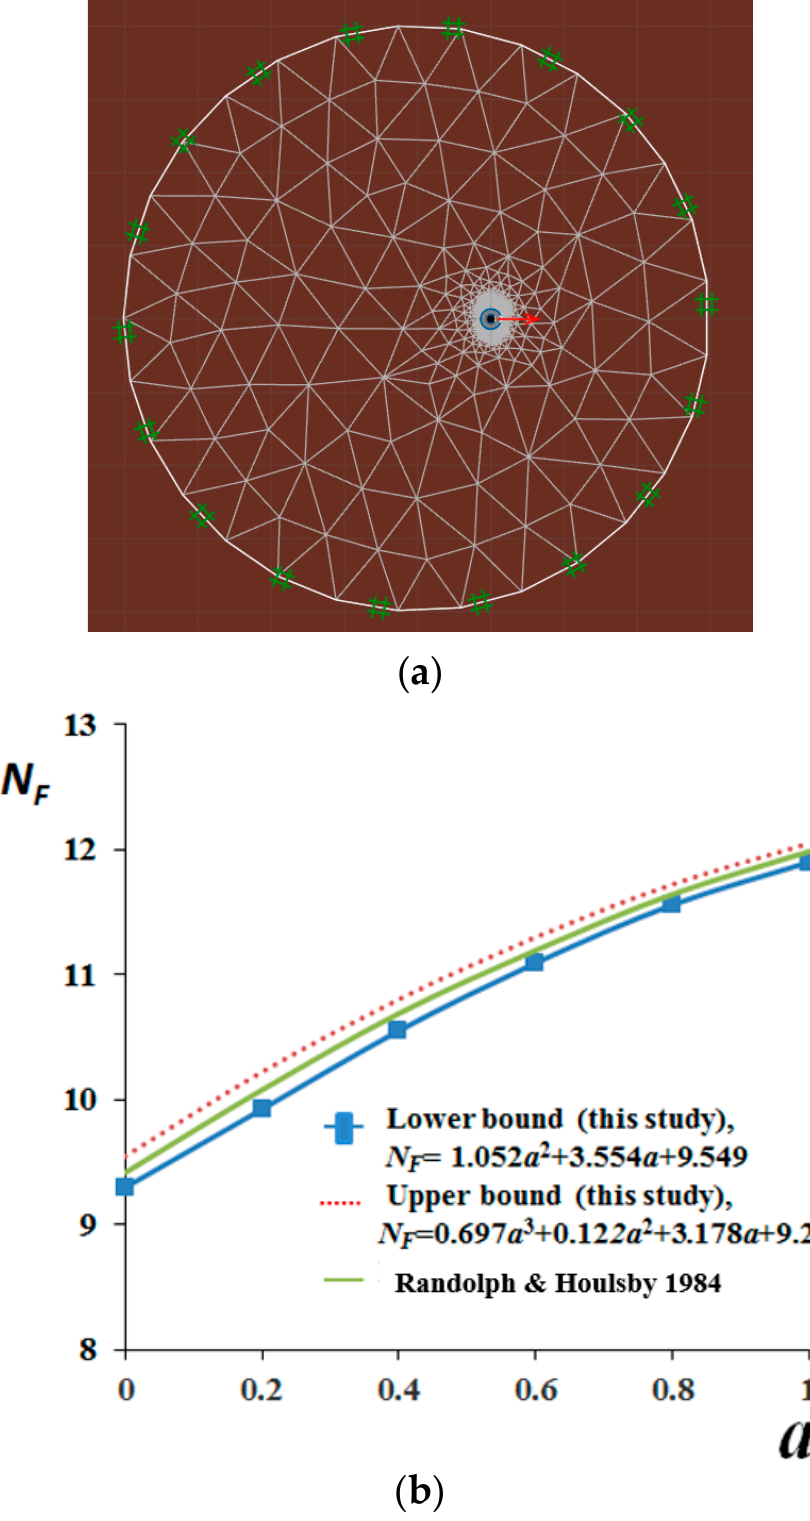
Figure 4. Calculation results for circular-pile model. ( a ) circular-pile-model self-adaptive computing grid; ( b ) a comparison of results calculated by Randolph and Houlsby (1984) with those using the method from this study. ( α : pile–soil interaction coefficient; N F : normalized ultimate lateral